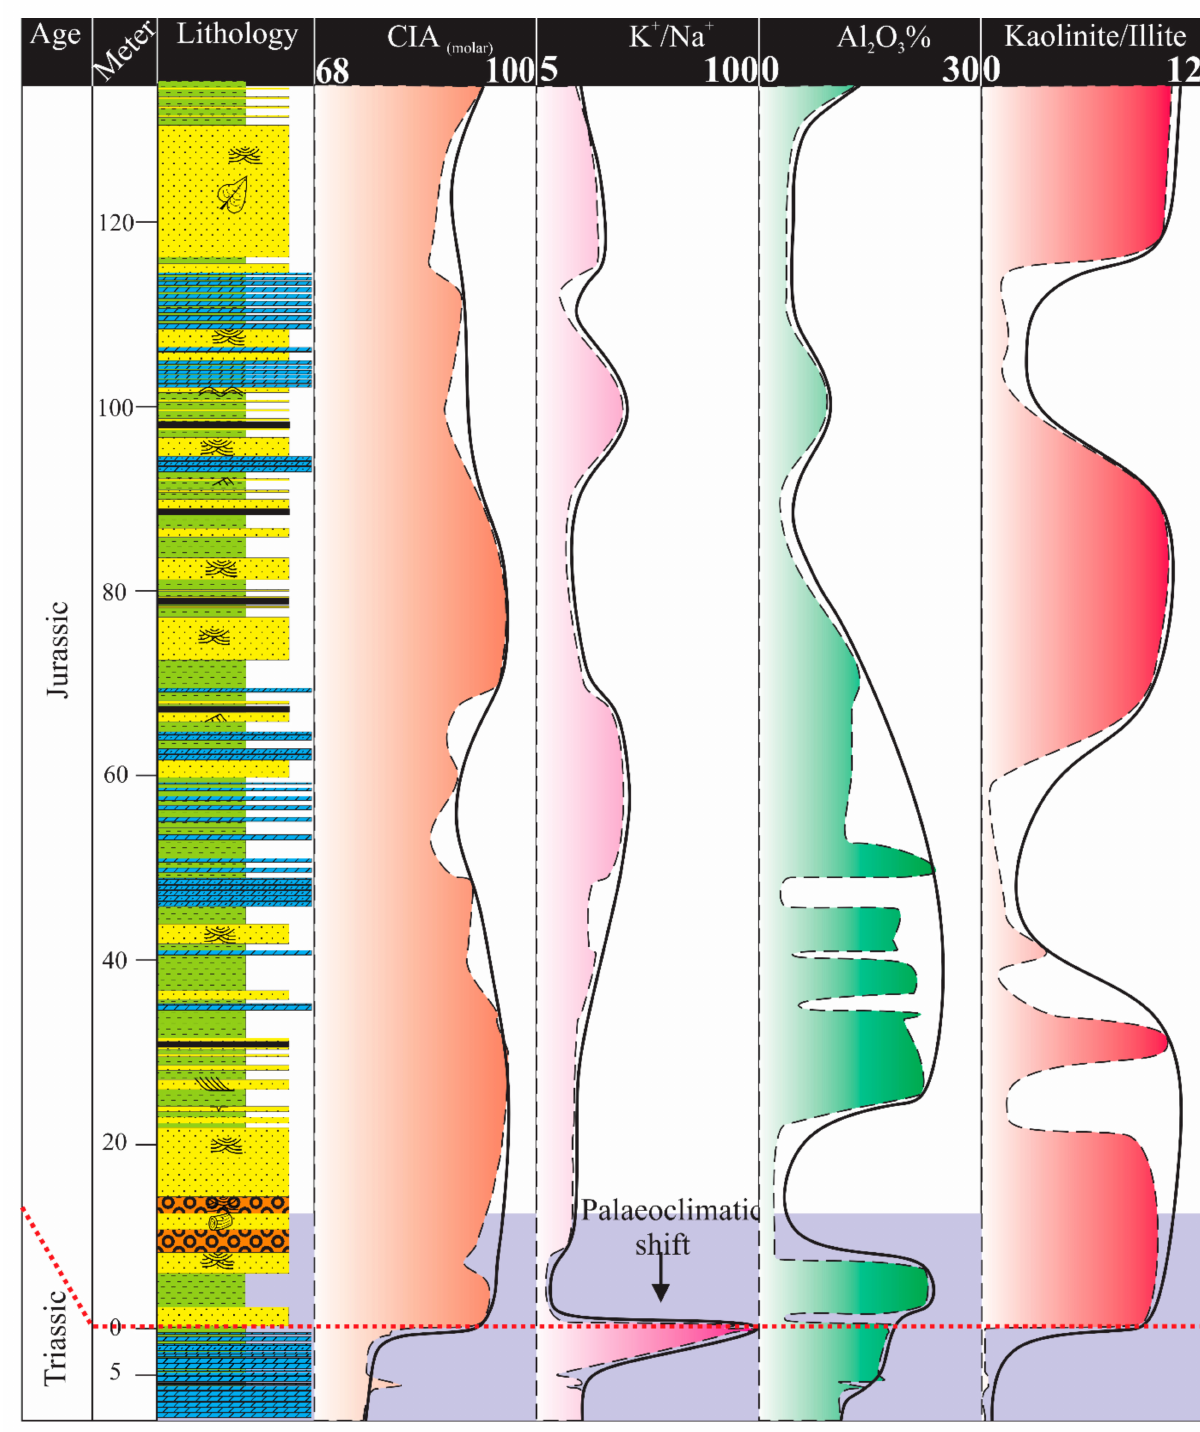
Figure 9. Lithological log of Nammal Gorge displaying vertical variation in Chemical Index of Alteration (CIA), K + /Na + , Al 2 O 3 , and kaolinite/illite ratio. Note the sudden change in all the weathering proxies at the TJB interval. The Nammal Gorge section was selected to overcome the artifact in CIA and other proxies owing to laterites as this section lacks thick